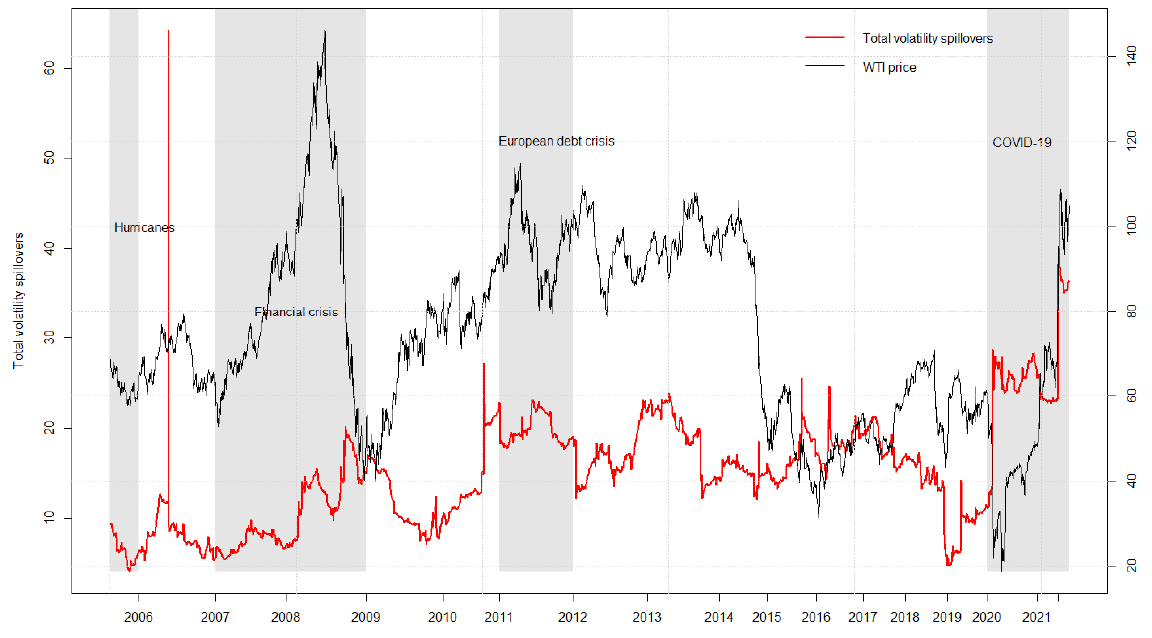
Figure 3. Total volatility spillovers and crude oil prices. Note: The shaded gray areas describe four specific intervals when major financial events happened during the sample period.